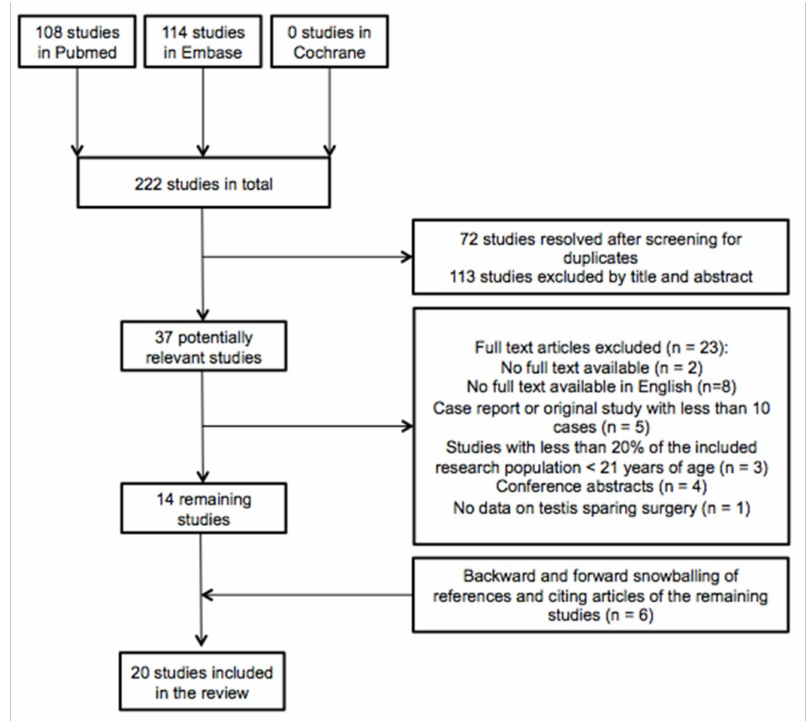
Figure 1. Flowchart of included and excluded articles during the search process.